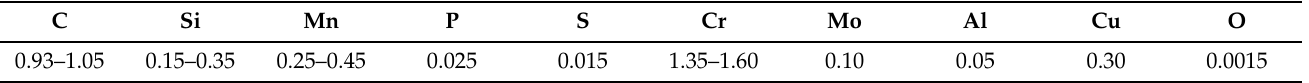
Table 1. Chemical composition of used bearing steel in % mass